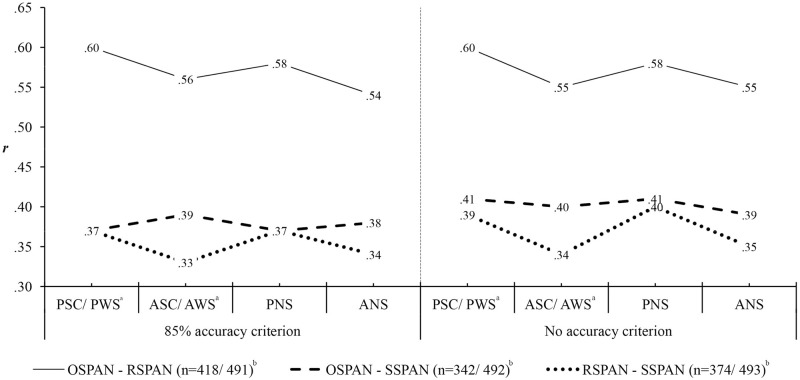
Correlations among equivalent working memory capacity (WMC) scores of different working memory (WM) span tasks according to the accuracy criterion on the processing component of the tasks.All ps <.001. OSPAN = operation span; RSPAN = reading span; SSPAN = symmetry span; PSC = partial score; ASC = absolute score; PNS = partial non-weighted score; ANS = absolute non-weighted score; PWS = partial weighted score; AWS = absolute weighted score. aAs PWS is a simple linear transformation of PSC, their intercorrelation is maximal (r = 1), and their correlations with other measures are identical. The same holds for AWS and ASC. bSize of the subsample of participants above the 85% accuracy criterion/ size of the full sample with no accuracy criterion.